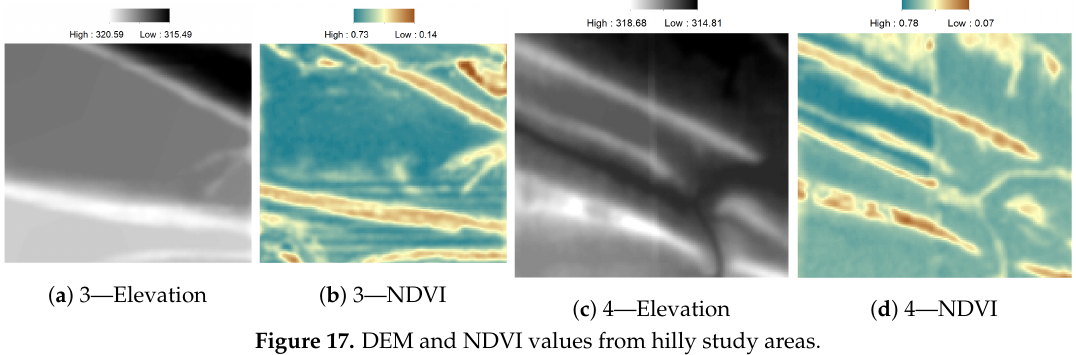
Figure 17. DEM and NDVI values from hilly study areas.